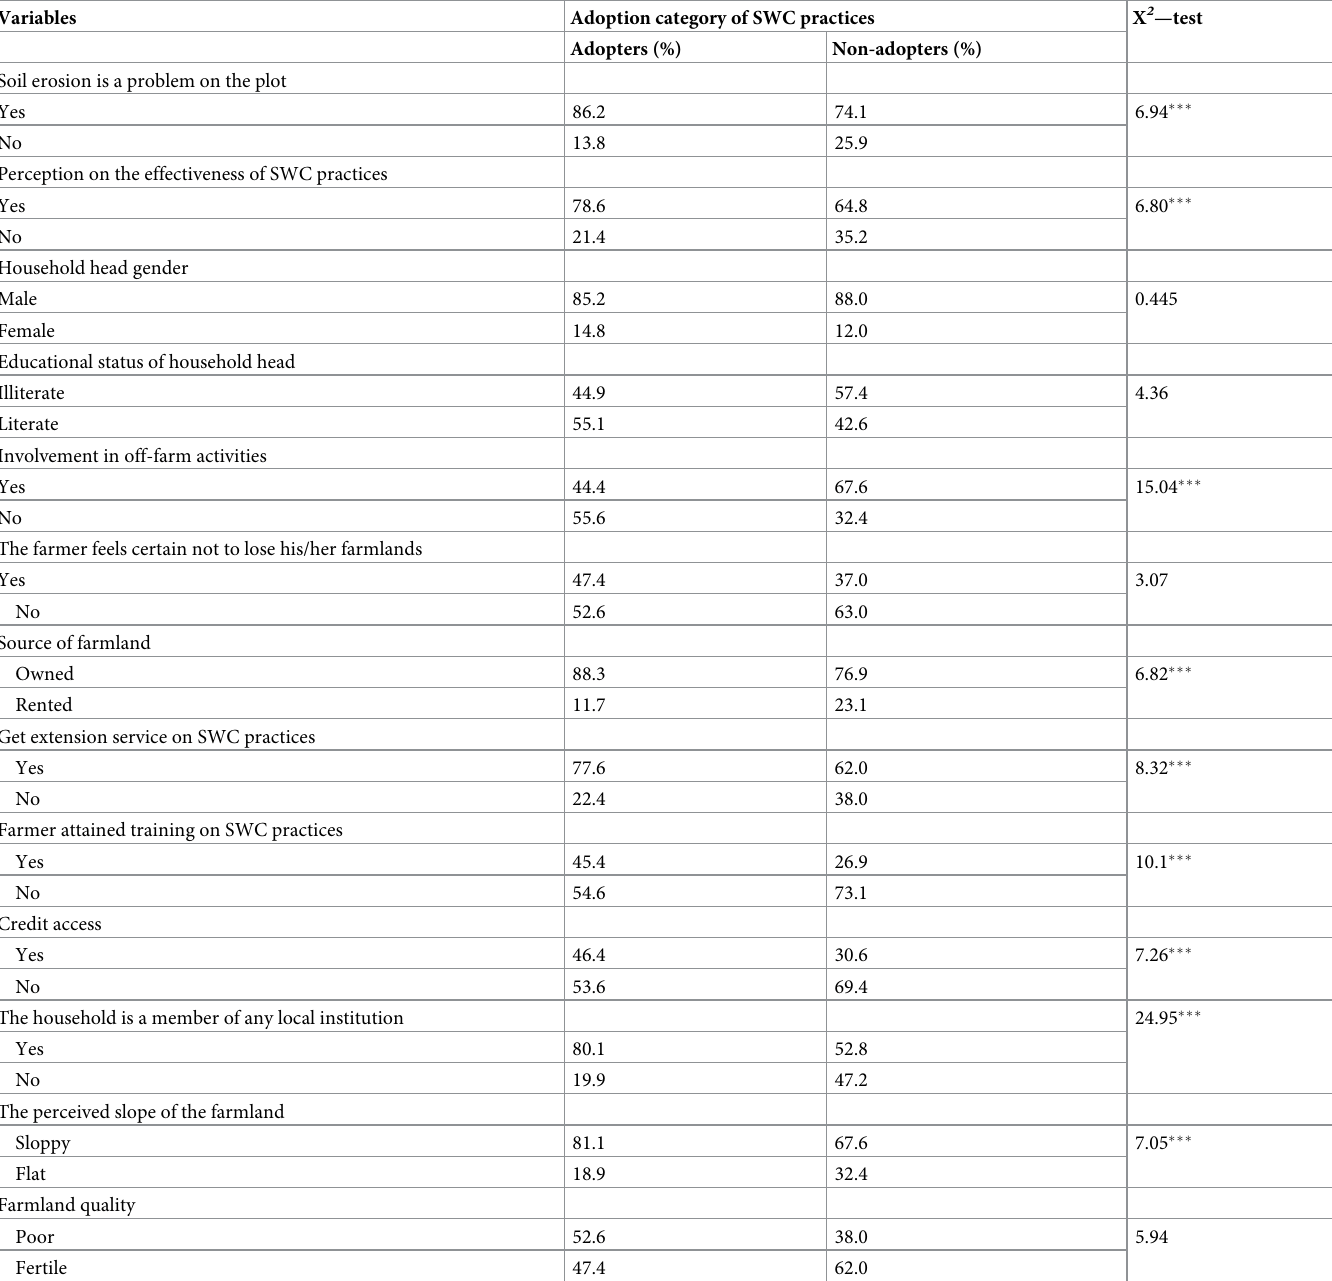
Table 3. Categorical variables distinguishing adopters from non-adopters of SWC practices in Lege-lafto